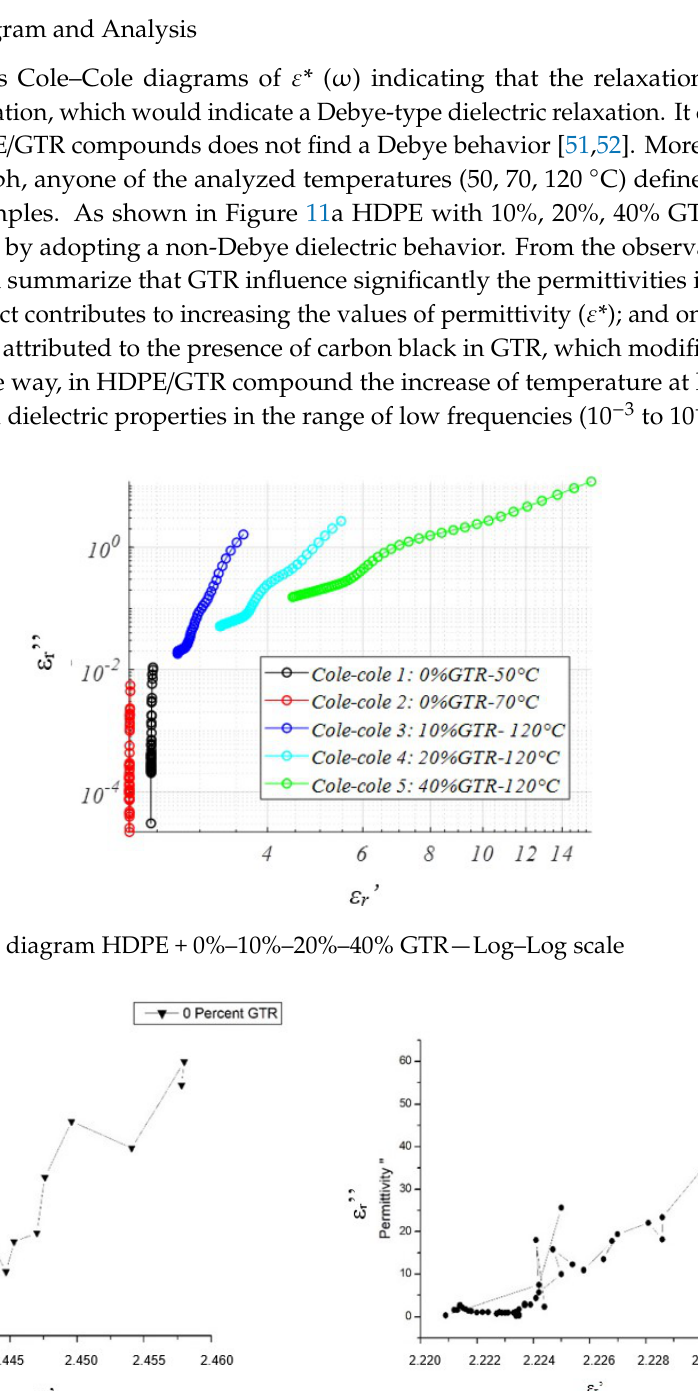
Figure 10. Loss rate of ( a ) neat HDPE and ( b ) HDPE + 40% GTR, as a function of frequency and at different temperatures. + 35 °C, □ 50 °C, ∆ 70 °C.